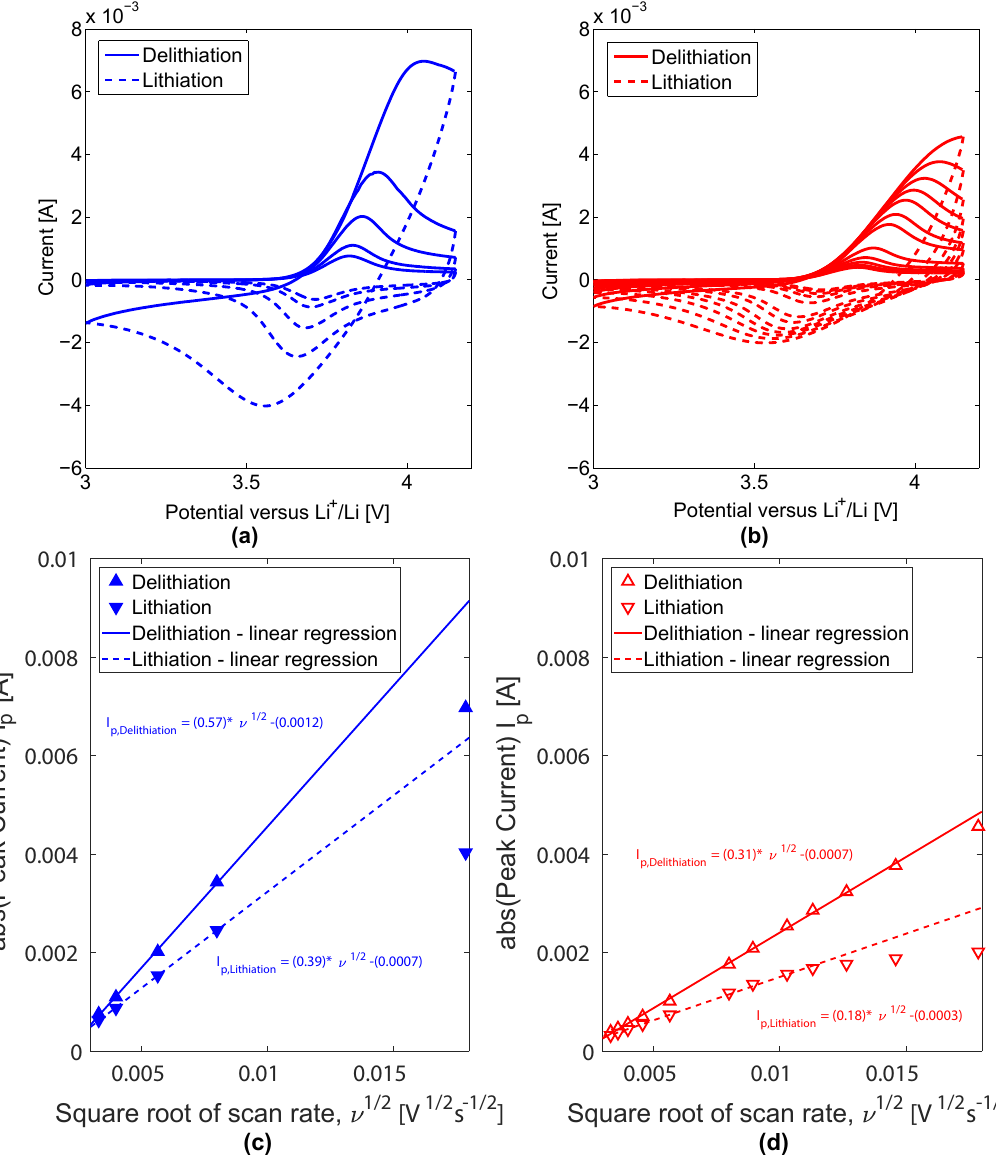
Figure 6. Cyclic voltammograms and redox peak currents as a function of the square root of the scan rate for uncycled and cycled positive electrodes. ( a ) Cyclic voltammograms at scan rates 0.011 mV · s − 1 , 0.016 mV · s − 1 , 0.032 mV · s − 1 , 0.064 mV · s − 1 , 0.319 mV · s − 1 for uncycled NMC electrodes. ( b ) Cyclic voltammograms at scan rates 0.011 mV · s − 1 , 0.013 mV · s − 1 , 0.016 mV · s − 1 , 0.021 mV · s − 1 , 0.032 mV · s − 1 , 0.064 mV · s − 1 , 0.080 mV · s − 1 , 0.106 mV · s − 1 , 0.128 mV · s − 1 , 0.160 mV · s − 1 , 0.213 mV · s − 1 , 0.319 mV · s − 1 for cycled NMC positive electrodes; Redox peak currents as a function of the square root of the scan rate for uncycled ( c ) and cycled ( d ) positive